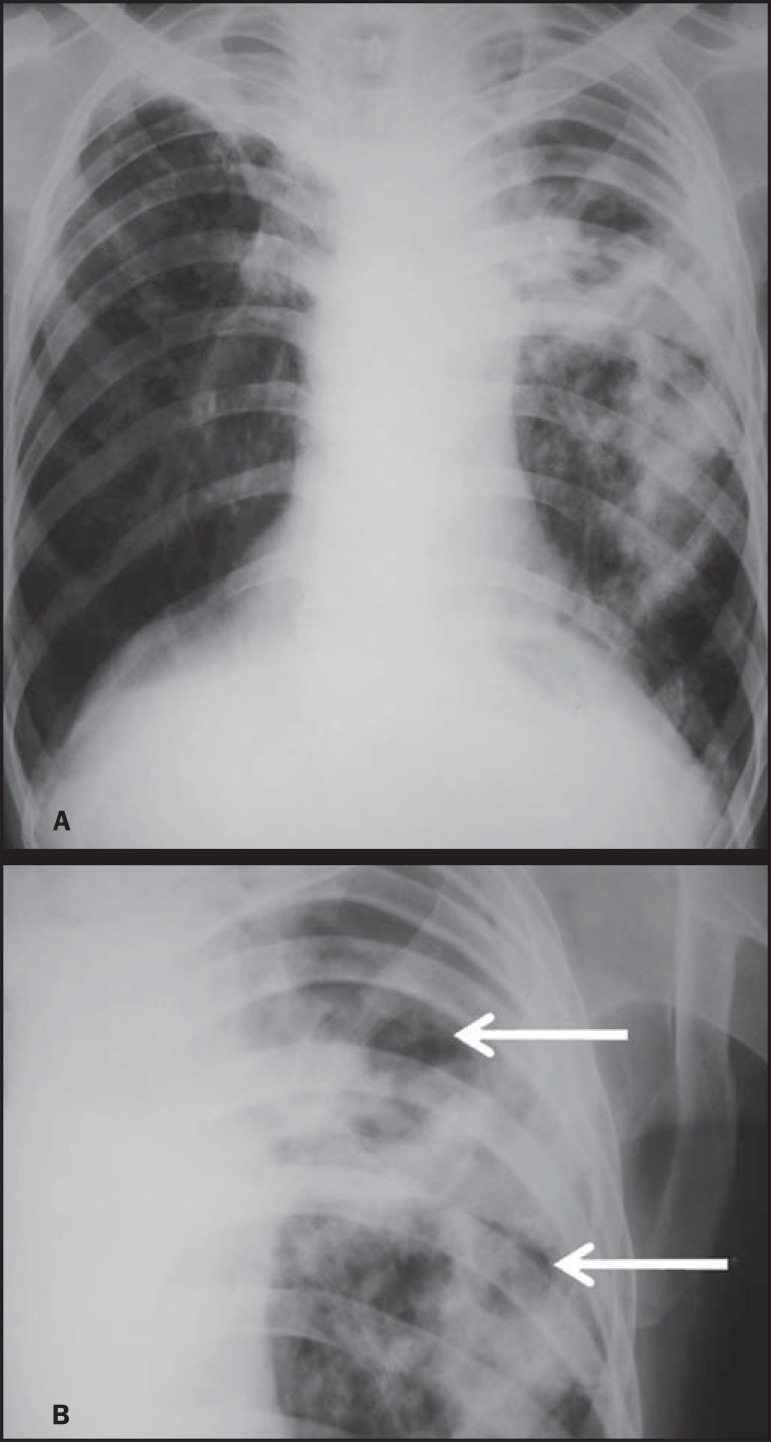
A 45-year-old man with (A) bilateral, superior pulmonary hilar
retraction and (B) pulmonary excavations (arrows) without fluid level
in the left hemithorax.